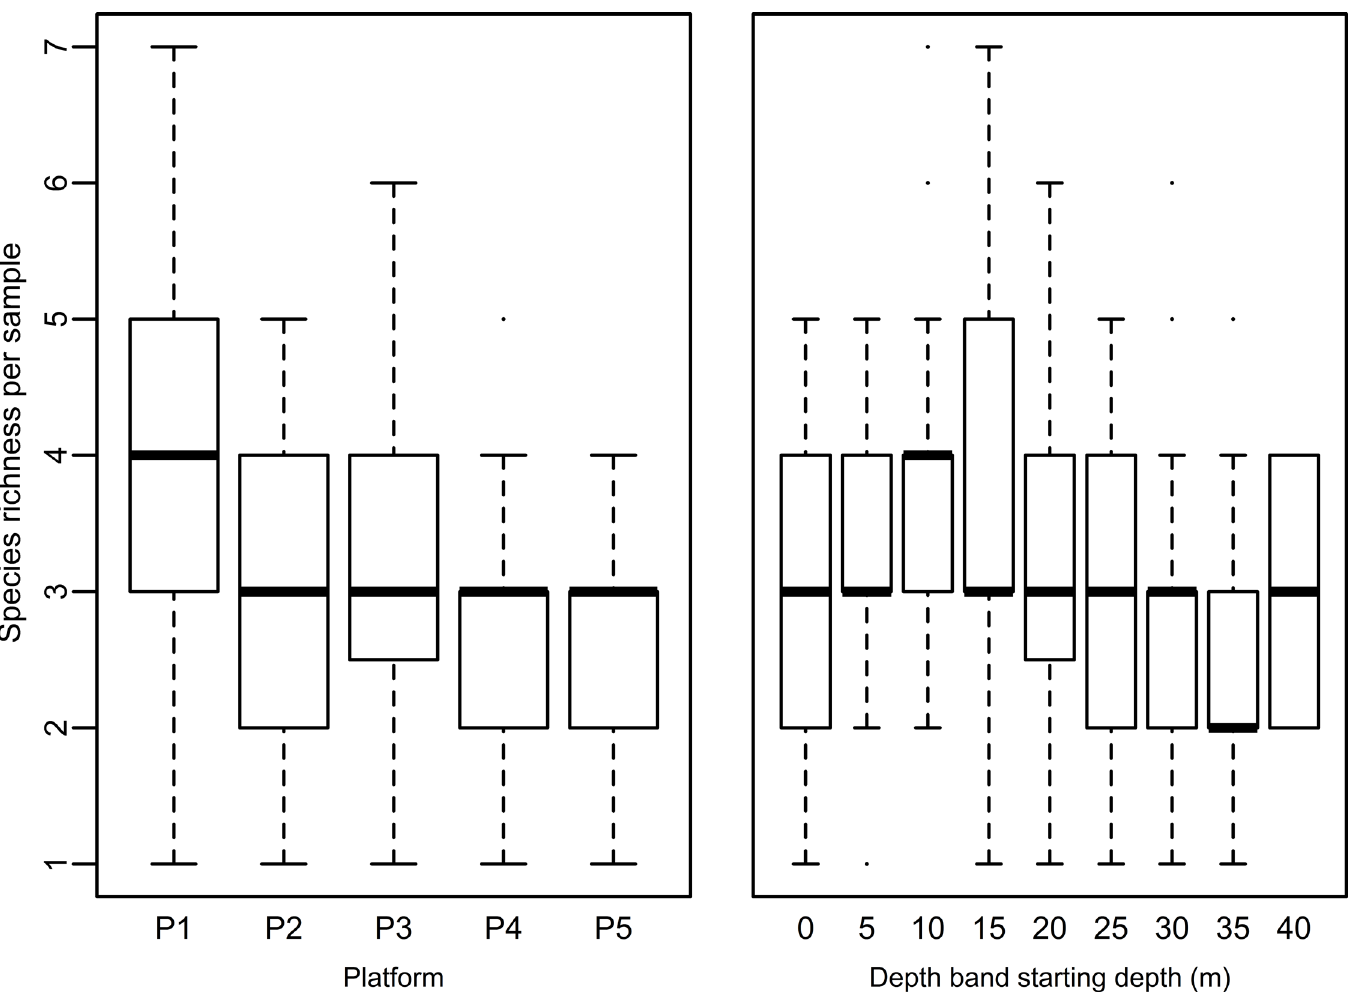
Fig 2. Species richness per platform & depth band. Boxplot showing the number of species per sample (n = 215), per platform with all depths combined (left image) and per depth-band with all platforms (n = 5)